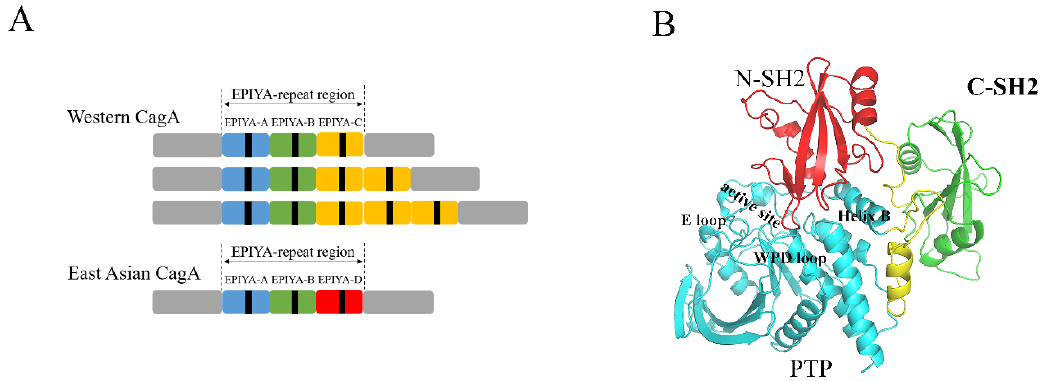
Figure 1. The structural diagram of H. pylori CagA ( A ). Each of the EPIYA segments contains a single EPIYA tyrosine phosphorylation motif (shown as a black box). The overall structure of SHP2 ( B ). The N-SH2 domain is shown in red, the C-SH2 domain is shown in green, and the PTP domain is shown in blue. The linker region is shown in yellow, and the active site and helix B are marked.